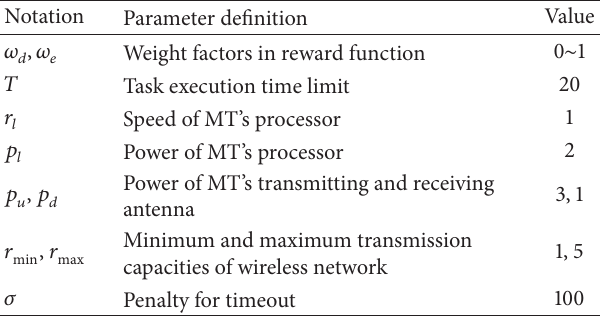
Table 5: Parameters in performance